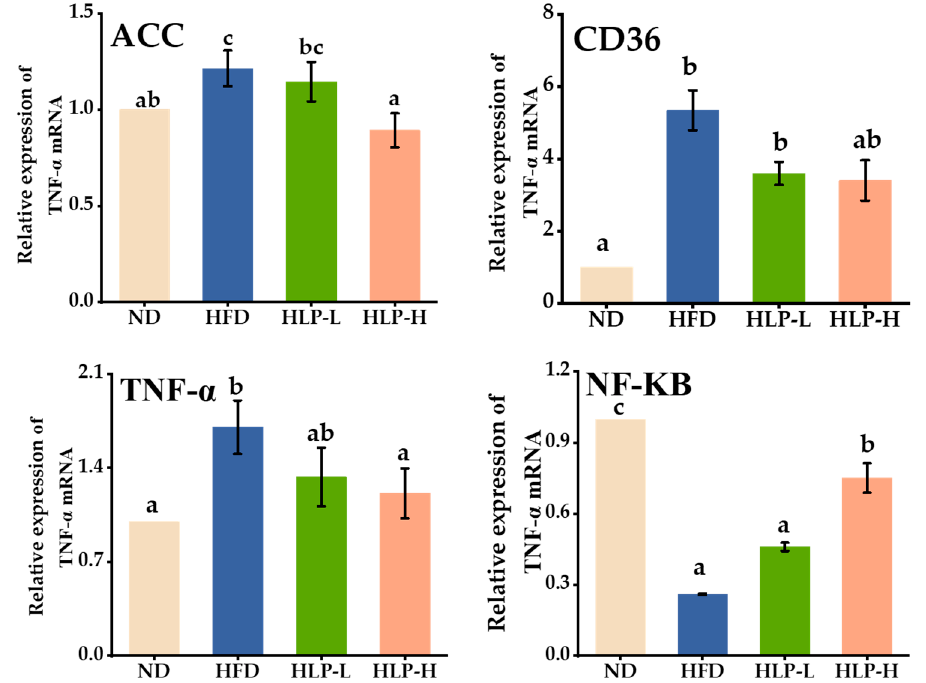
Figure 6. Effects of HLP on the expression of lipogenesis-related mRNA. Data are presented as means ± SEM ( n = 8). Values with different superscripts represent significant differences ( p < 0.05).